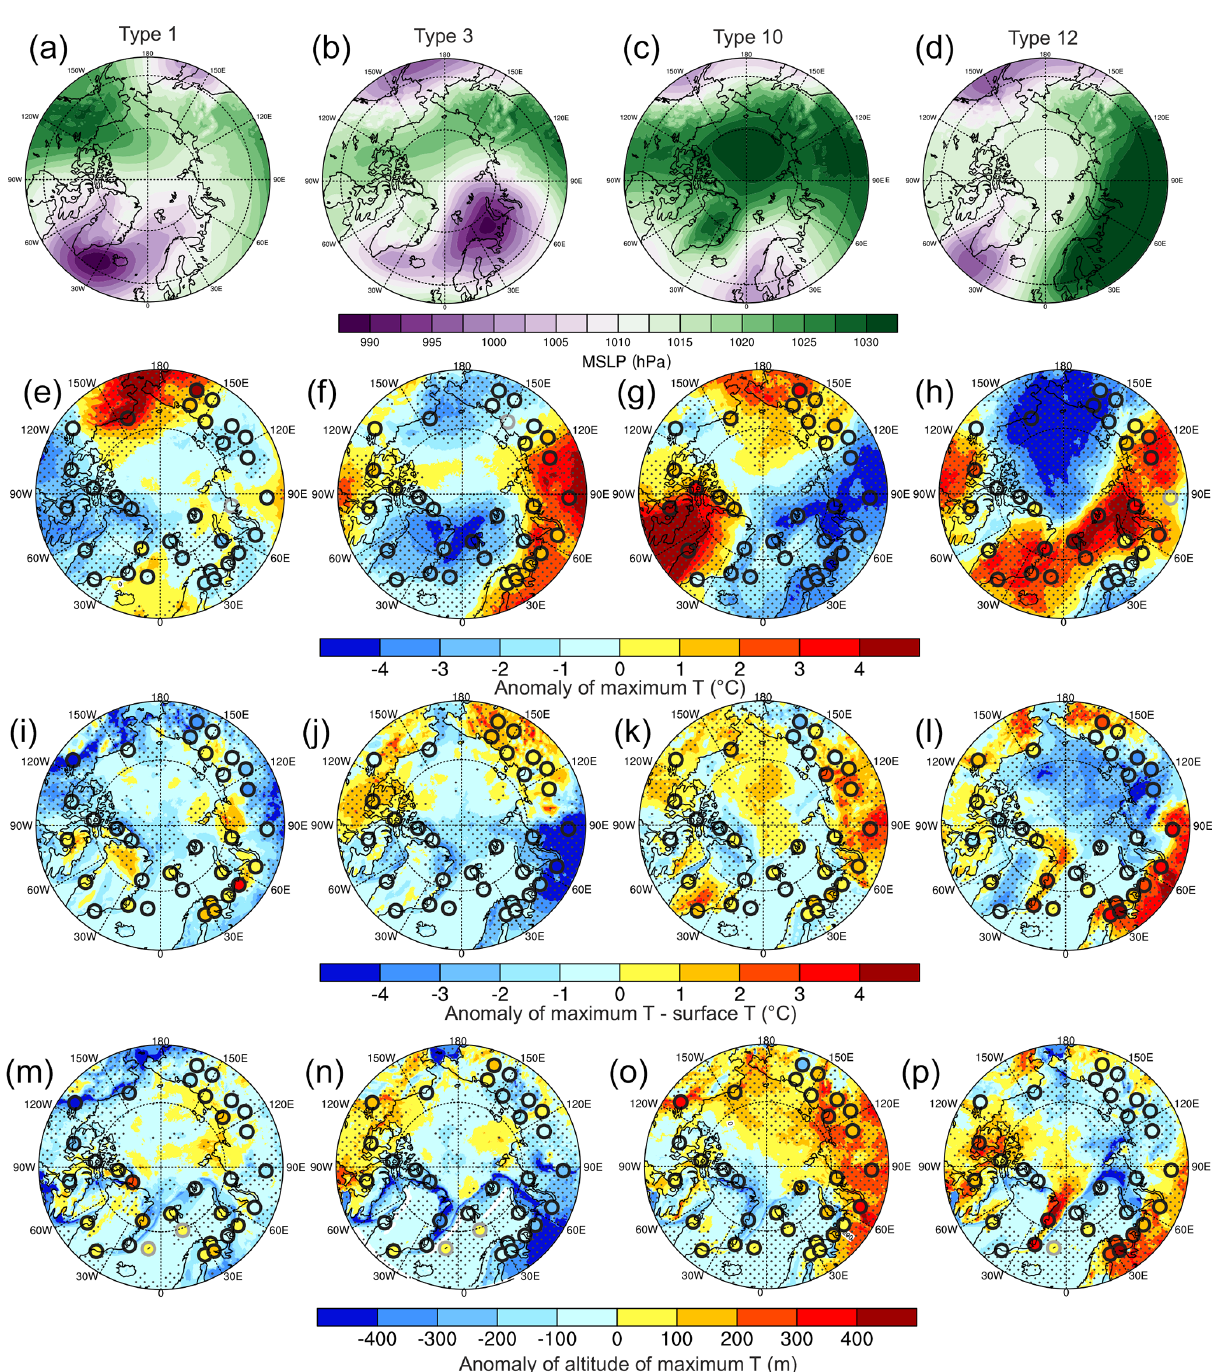
Figure 6. Mean sea level pressure (a–d) , anomaly of vertical maximum T (e–h) , anomaly of vertical maximum T − surface T (bulk inversion strength) (i–l) , anomaly of altitude of vertical maximum T (m–p) in four SOM circulation types (indicated on the top of the column) in December–February 2009–2018. The colours inside the circles show values based on radiosonde observations, whereas the fields are based on ERA5. The dotted shadings (ERA5) and black circles (radiosonde observations) show the anomalies that are different from zero at the 99% significance